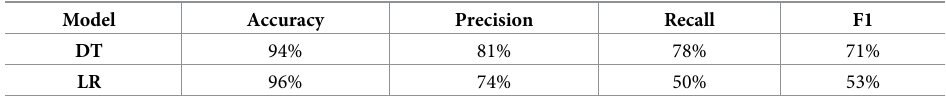
Table 4. Performance of testing on original dataset with generated dataset.